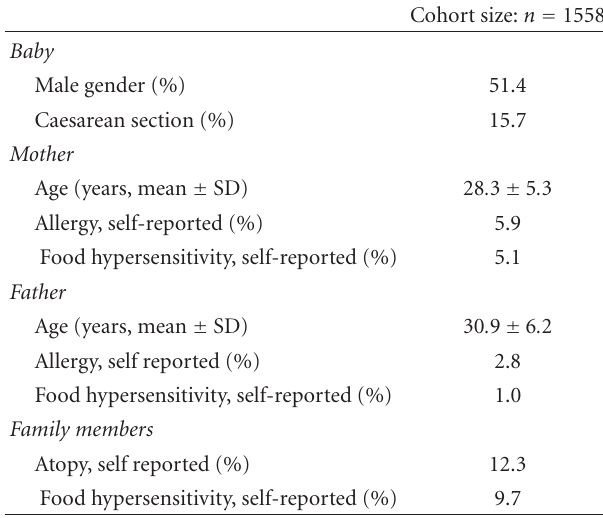
Table 1: Characteristics of the Lithuanian birth cohort “Alergemol” and the number of self-reported cases of allergy and food hypersen- sitivity of the family